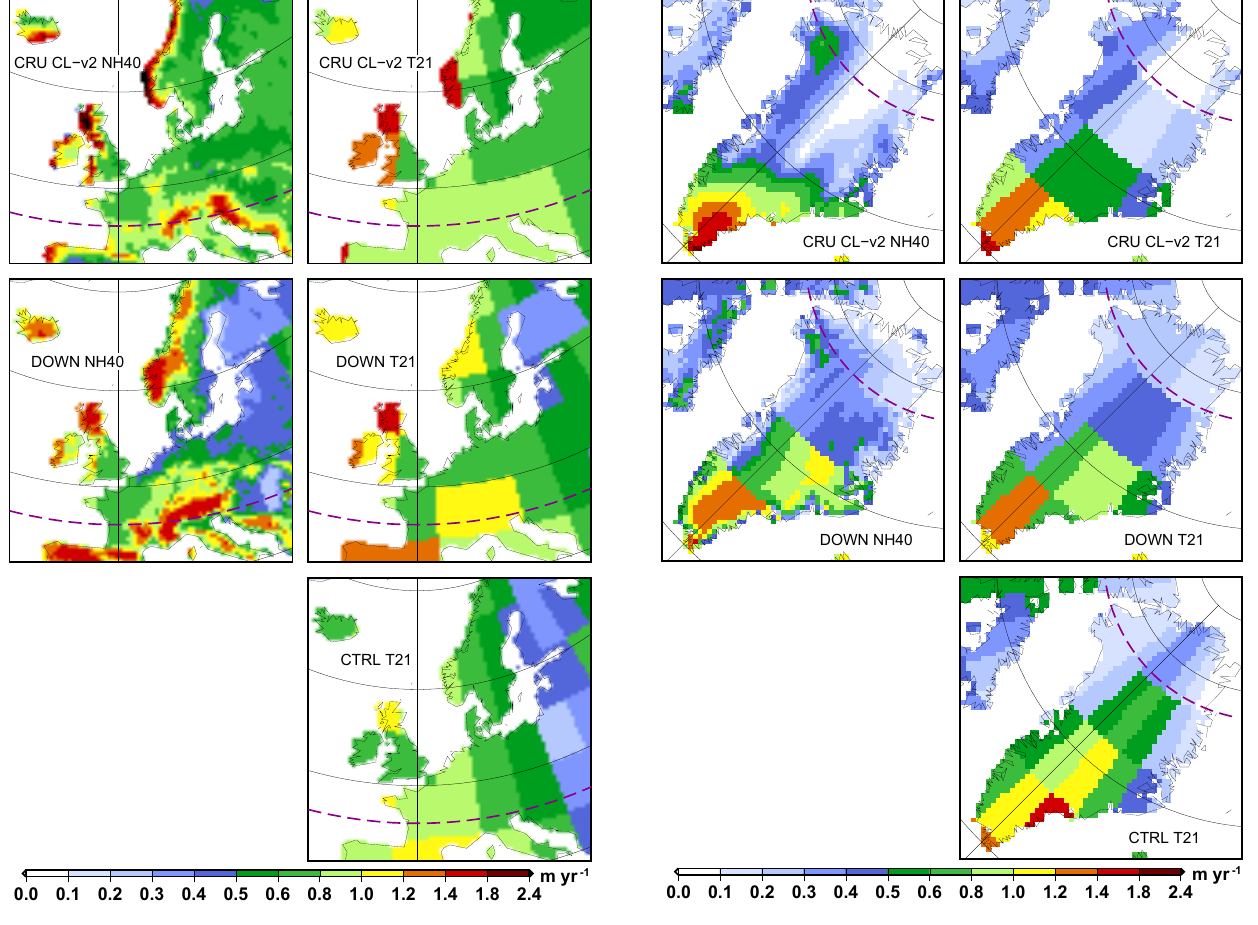
Figure 7. Same as Fig. 6 but zoomed over Europe. Figure 8. Same as Fig. 6 but zoomed over